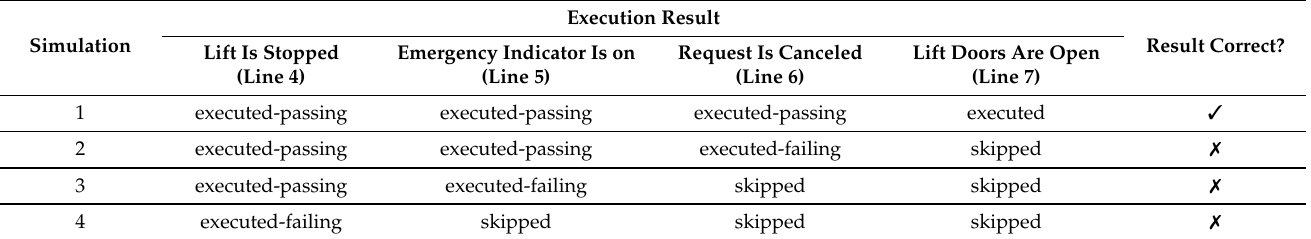
Table 4. Simulation results of executing the lift safety specification in Figure 3: behave with